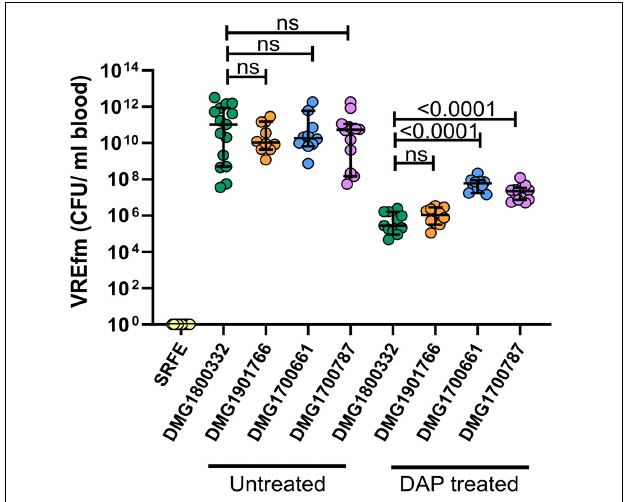
FIGURE 4 | Efficacy of daptomycin treatment in a mouse model of VREfm bacteraemia. VREfm blood counts in uninfected mice administered sterile rate faecal extract (SRFE) or in mice infected with the daptomycin-susceptible isolate DMG1800332 (green) or daptomycin-resistant isolates DMG1901766 (orange), DMG1700661 (blue), or DMG1700787 (purple), and treated with either saline (untreated) or 50 mg/kg of daptomycin (DAP treated). Each coloured circle represents one animal ( n = 10–15 mice), with the median value displayed by the horizontal black line. Error bars represent the 95% CI. p -Values were calculated using a Mann–Whitney non-parametric test and are shown for the indicated groups; ns indicates no significant difference between groups ( p ≥